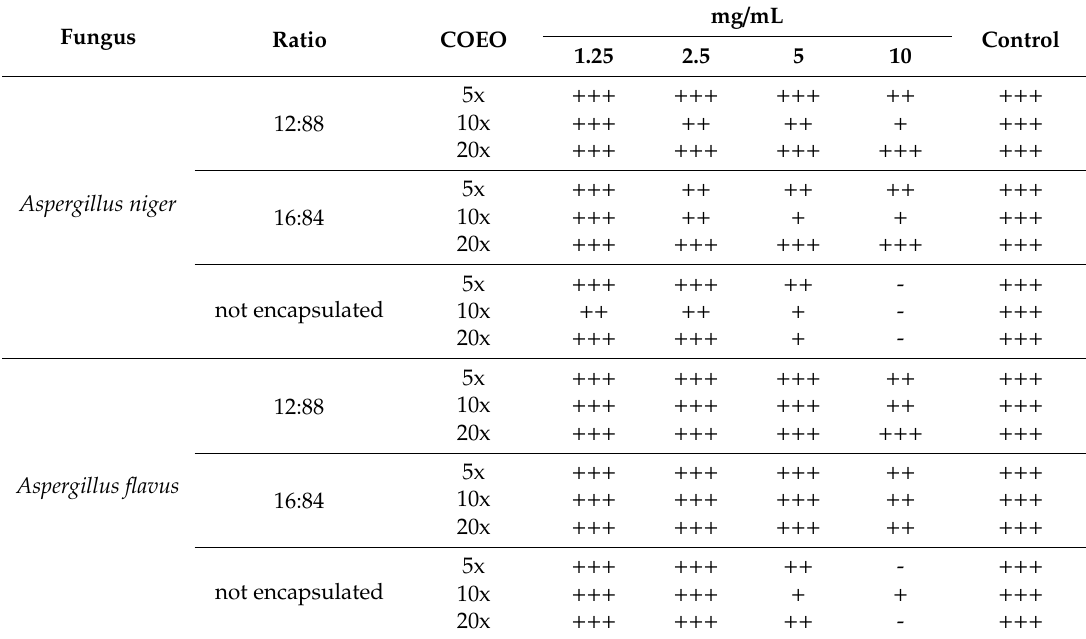
Table 4. Measure of mycelial growth in the presence of inclusion complexes (COEO: β –CD). Fungus Ratio COEO